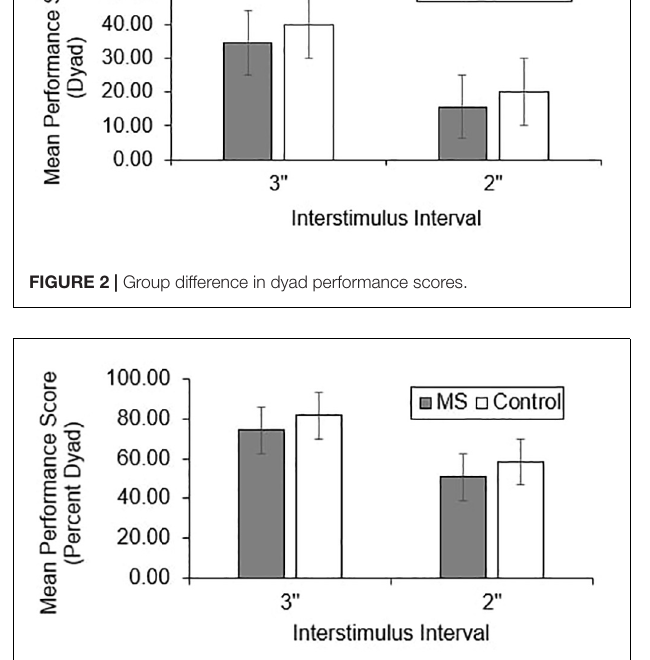
FIGURE 3 | Group difference in percent dyad performance scores.